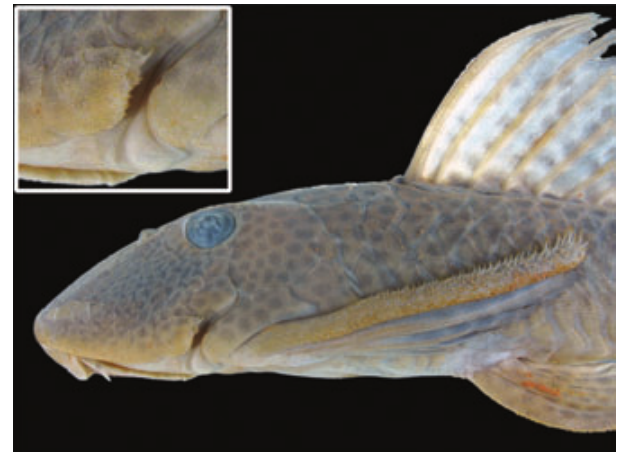
Fig. 2. Head and anterior portion of body in lateral view of Hypostomus kuarup , MZUSP 94864, 147.0 mm SL. Inset box on upper left corner show detail of odontodes development on cheek plates.